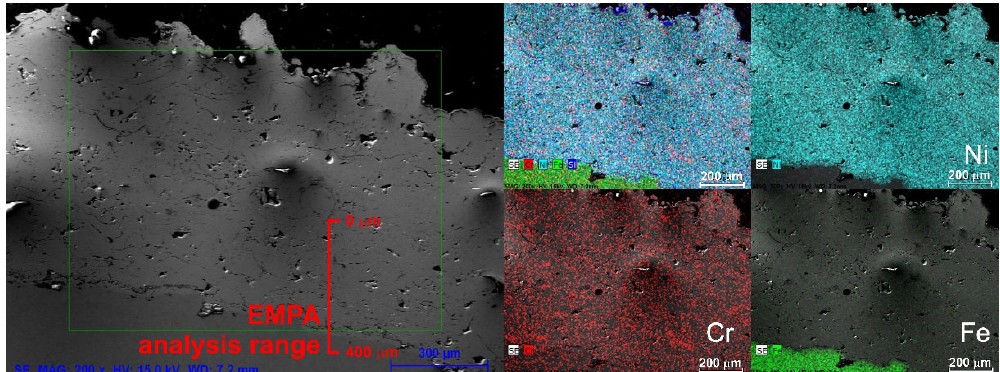
Figure 10. SEM/EDX image of the Plasma coating after 5000 h at 600 °C.